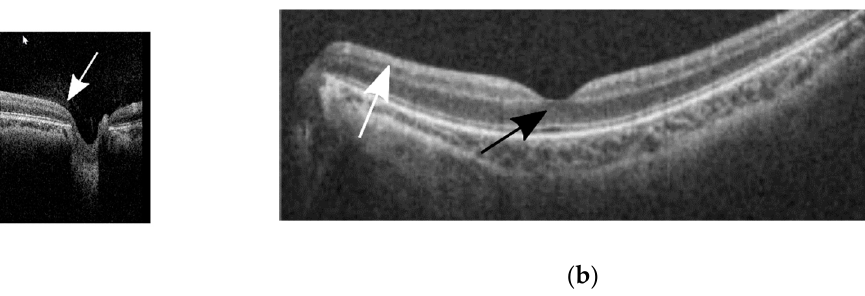
Figure 3. Optical coherence tomography (OCT) of the right ( a ) and left ( b ) macula of the child shows formed fovea in both eyes (black arrows) and a thin retinal neuron fiber layer (white arrows).